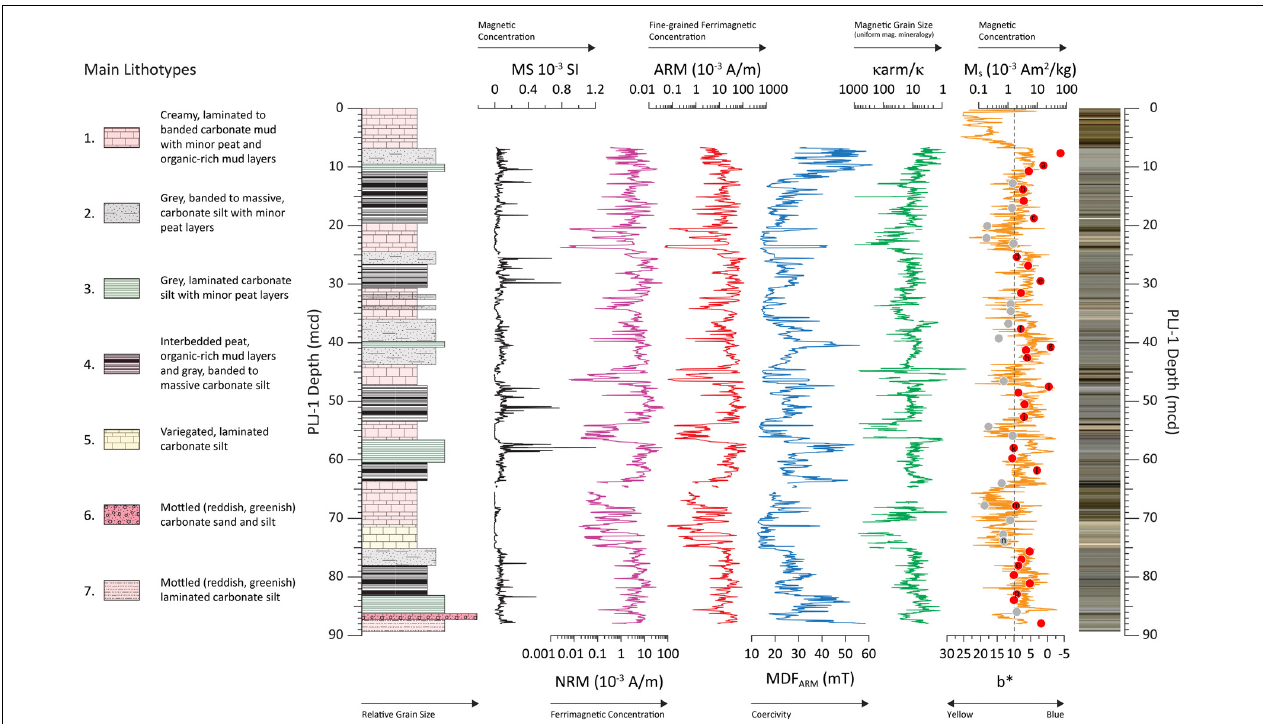
FIGURE 2 | From left to right. Stratigraphic column of the Lake Junín splice from Chen et al. (2020). Downcore u-channel derived magnetic properties; magnetic susceptibility (black line), natural remanent magnetization (NRM) (purple line), anhysteretic remanent magnetization (ARM) (red line), median destructive field of the ARM (blue line), and κ arm/ κ (green line). Downcore physical properties; b * color index (orange line) and the synthetic color profile generated from the spectrophotometer. Discrete sample, paramagnetic slope corrected, M s values [red ( > 1.5 × 10 - 3 Am 2 /kg) and gray ( < 1.5 × 10 - 3 Am 2 /kg) symbols] overlie the b * color index. Gaps in the κ arm/ κ record relate to negative κ arm/ κ values that cannot be plotted on the x -axis logarithmic scale, letter annotations on the M s data are used as sample identifiers across Figures 3 , 4 . Note the prominent shifts across, and sensitivity of, all five magnetic property datasets associated with visible changes in sediment color and generalized